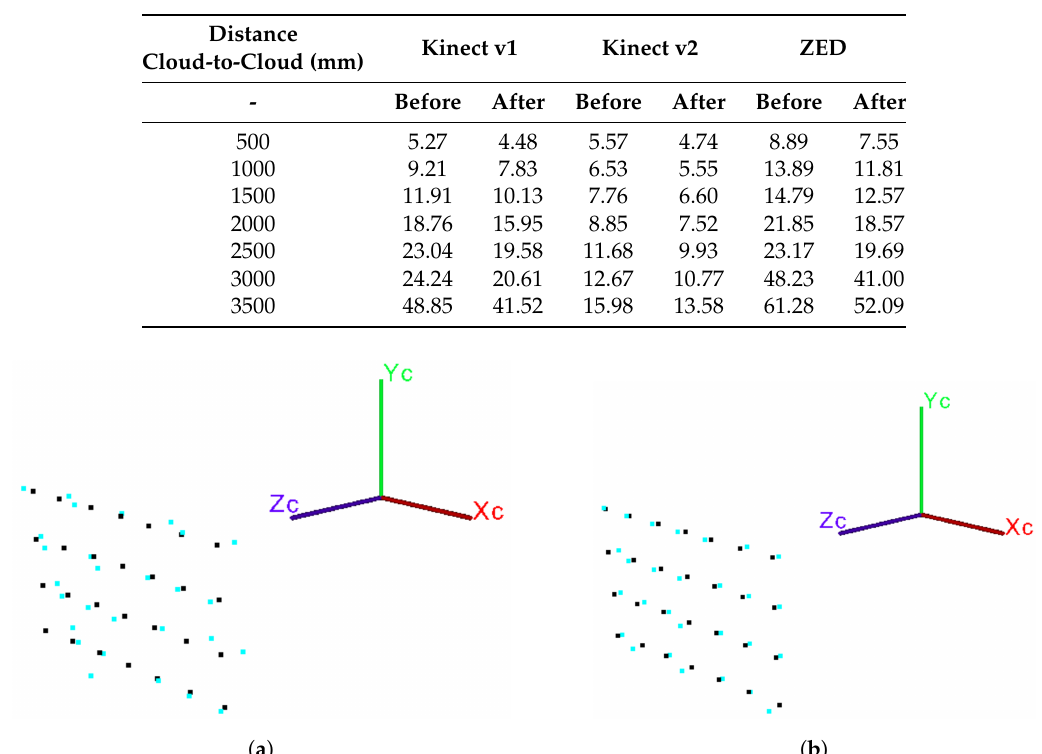
Table 4. RMS Error in millimeters for the rigid registration, before and after correction of the point clouds.